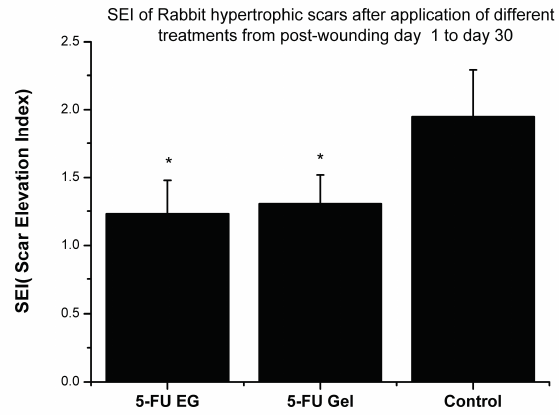
Figure 7. Scar elevation index (SEI) of rabbit hypertrophic scars after application of different treatments from postwounding day 1 to day 30. Values were expressed as the mean ± SD. n = 14 . * p < 0.05 compared to control samples using one-way ANOVA.